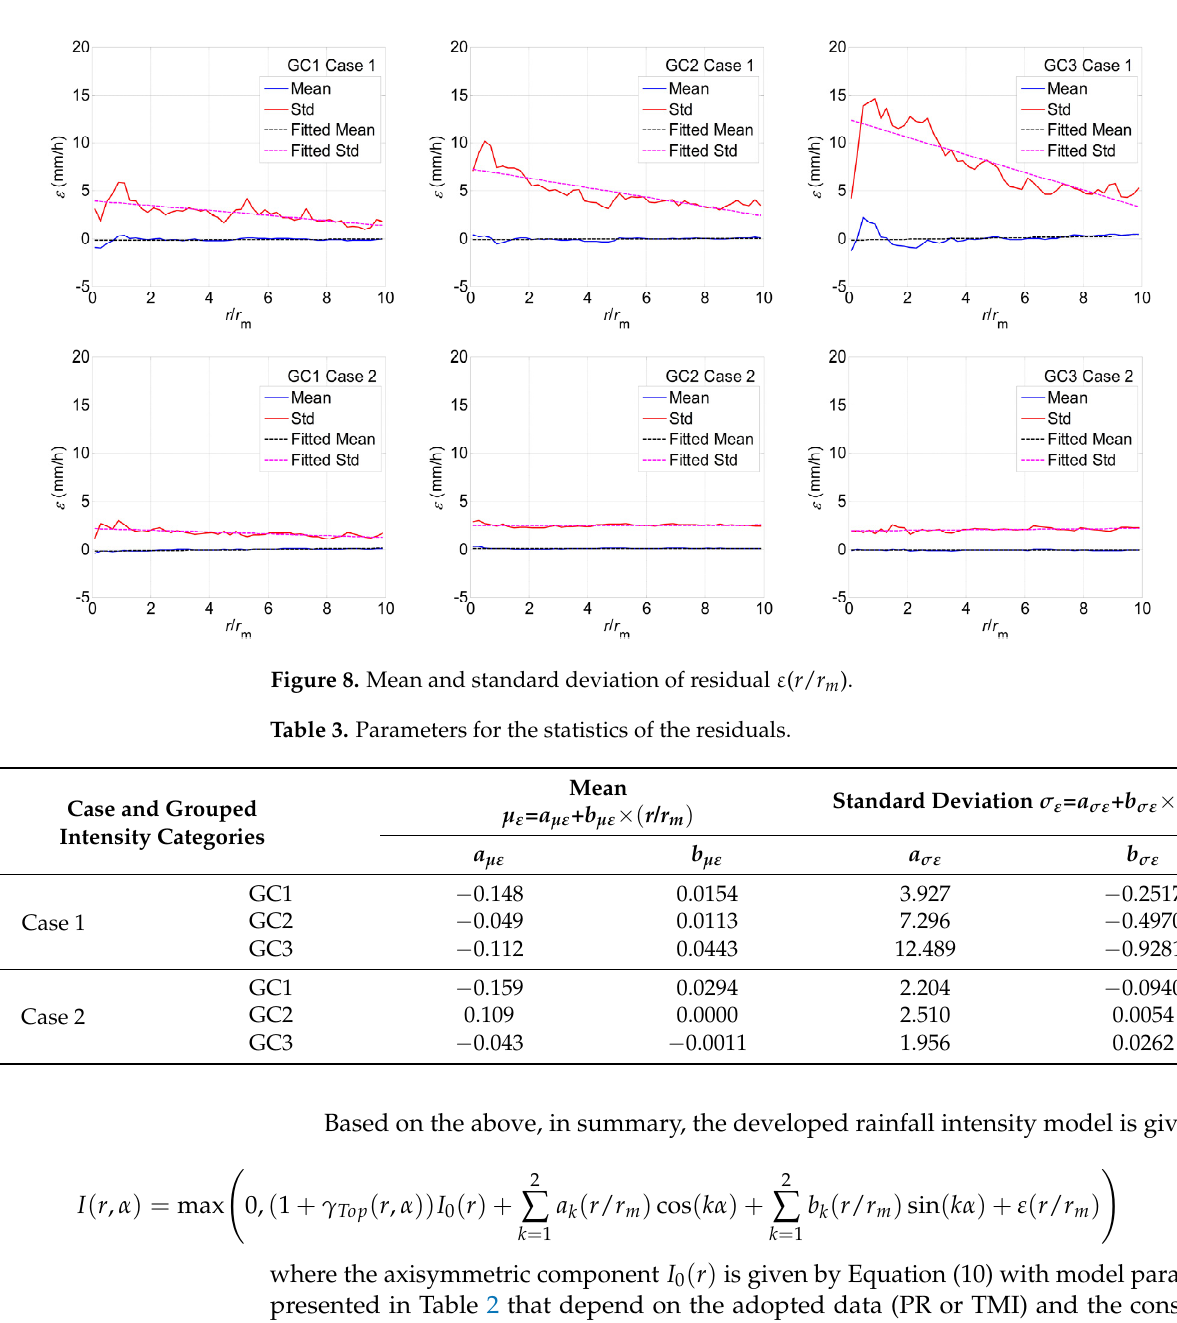
Figure 9. Illustration of the TC tracks for a period of 10 years: ( a ) Using historical TC tracks from 2001 to 2010 based on the historical catalogue given in Ying et al. (2014) and ( b ) Using synthetic TC tracks generated by applying the model given in Li and Hong (2016) for a period of 10 years.